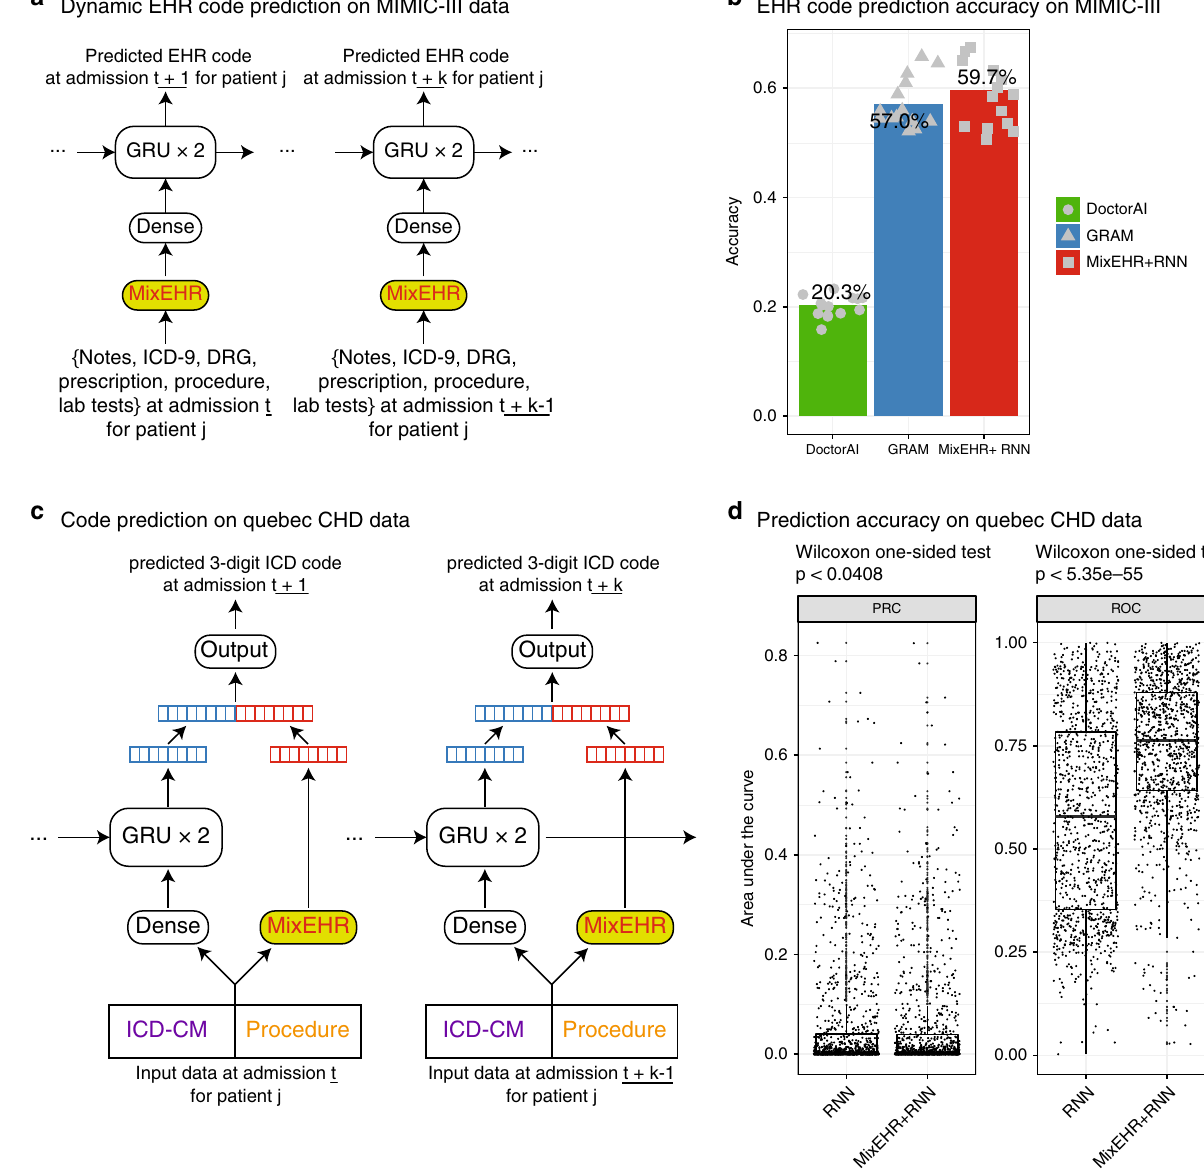
Fig. 6 Diagnostic code prediction using the MIMIC-III and Quebec CHD datasets. a Proposed MixEHR + RNN framework for predicting medical code from the MIMIC-III data. b Medical code-prediction accuracy. We evaluated the prediction accuracy of the 42 common Clinical Classi fi cation Software (CCS) medical codes comparing MixEHR with Doctor AI and GRAM. For each medical code, the accuracy was calculated by the true positives among the top 20 predicted codes divided by the total number of positives. The dots are individual accuracies for each code predicted by each method. c Proposed MixEHR + RNN framework for predicting the ICD code on Quebec CHD database. d Prediction accuracies in terms of area under the precision – recall curve (AUPRC) and area under the ROC curve (AUROC) over all of the 1098 3-digit ICD codes. The center line, bounds, and whiskers of the boxplots are median, fi rst and third quartiles, and outlier, respectively. Wilcoxon signed-rank one-sided tests were performed to calculate the p-values with the alternative hypothesis set to that AUCs from MixEHR + RNN are greater than the AUCs from the baseline